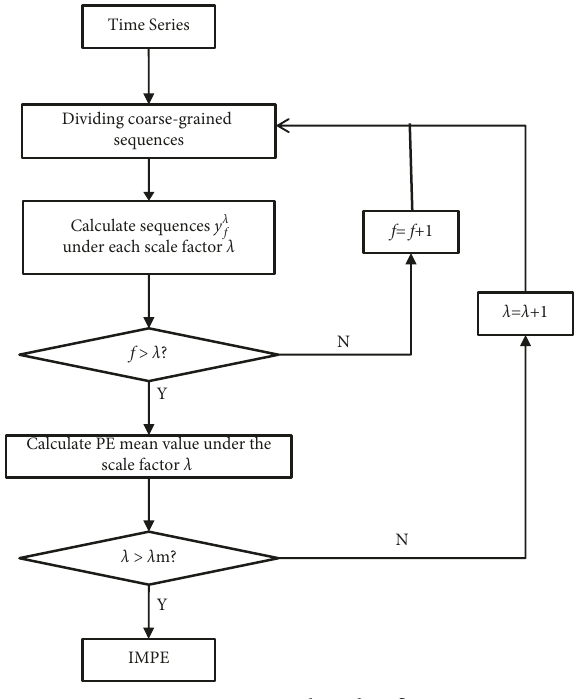
Figure 2: IMPE algorithm